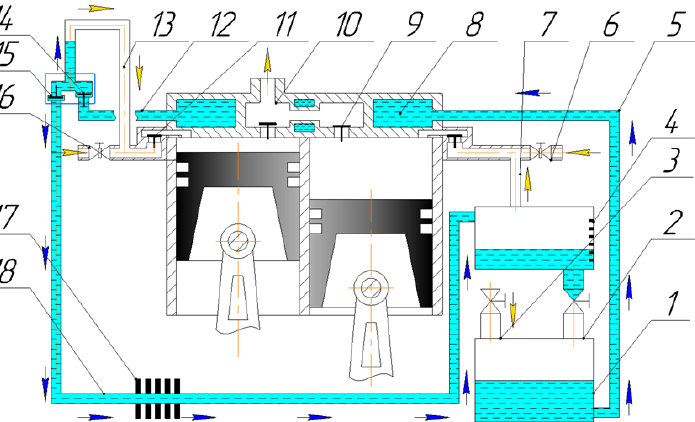
Figure 4. Schematic diagram of the machine: 1 — Tank with coolant; 2 — Branch pipe with a valve connecting the measuring tank to the liquid container; 3 — Branch pipe with a valve connecting the tank to the atmosphere; 4 — Volume-calibrated scale of liquid level in a measuring container; 5 — Coolant supply pipe; 6 — Throttle gas suction line; 7 — Pipe connecting the measuring tank to suction